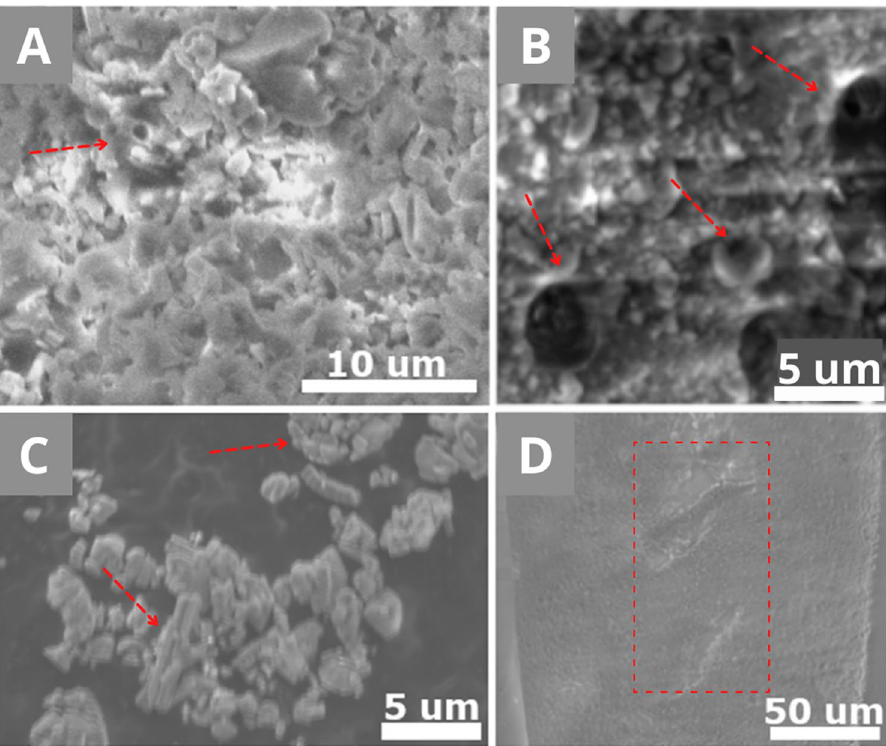
Figure 1. MIRA3 XMU SEM-SE images of charging effects. ( A ) and ( C ) are chalk powder composed of calcareous nannofossils; ( B ) and ( D ) show the surface of a foraminifera Uvigerina sp. The red arrows and frame show the material planned to be studied. (A) Uneven brightness creates bright spots and too dark areas, hiding features of the sample. (B) Bright lines created by charging do not allow the interpretation of the